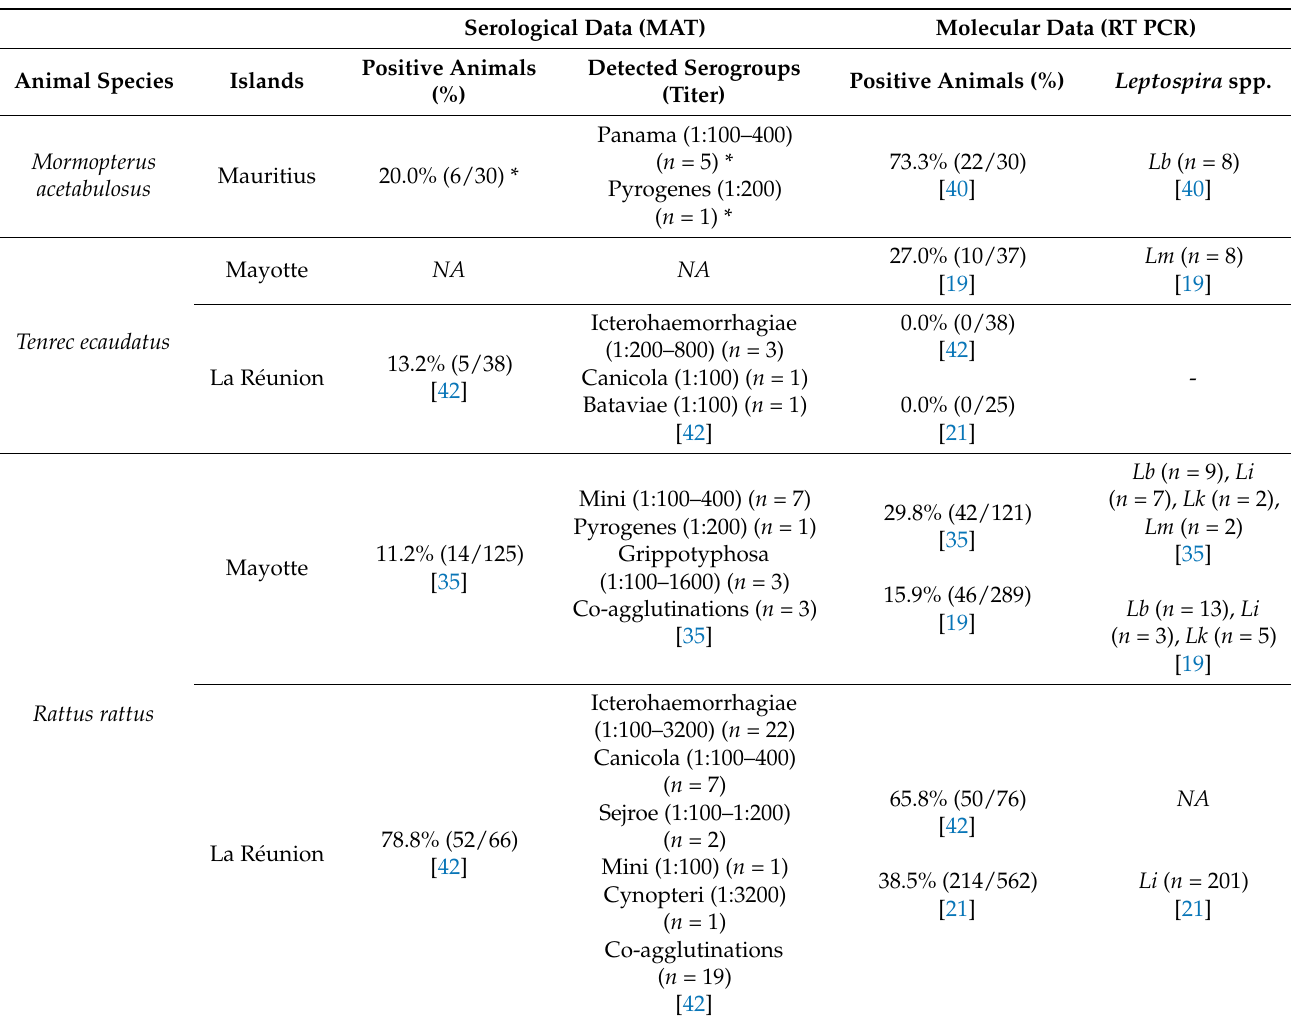
Table 2. Comparison of serological and molecular Leptospira data obtained from the investigated animal species. Serological Data (MAT) Molecular Data (RT PCR) Animal